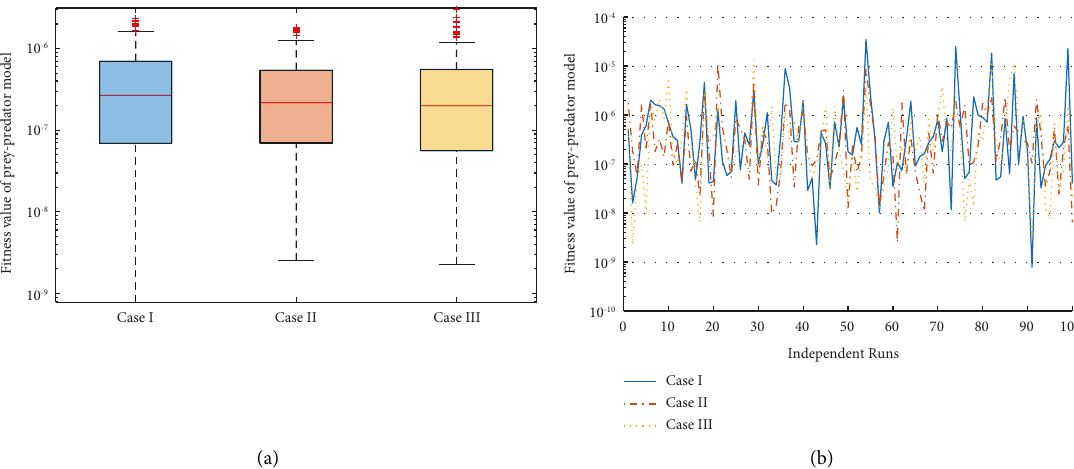
Figure 14: Comparison between the box plots and convergence graphs of fitness evaluation over 100 independent runs for the prey- predator model with variations in β . (a) Box plots for fitness evaluation of the prey-predator model with variations in β 2 . the fitness value of the prey-predator model with variations in β 2 Table 31: Convergence analysis of population density of local, immigrant prey, and predator under the influence of variations in β Cases